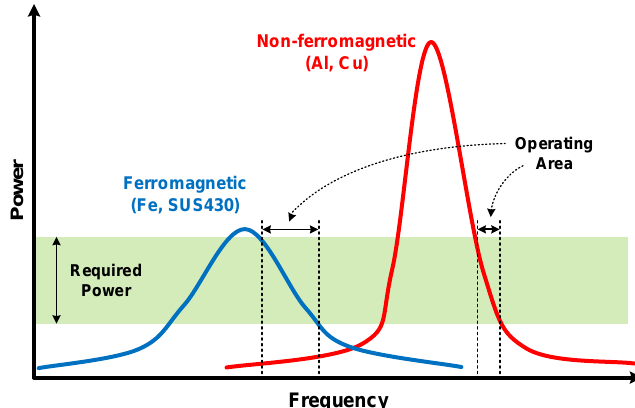
Figure 2. Induction heating operation area according to pot material.